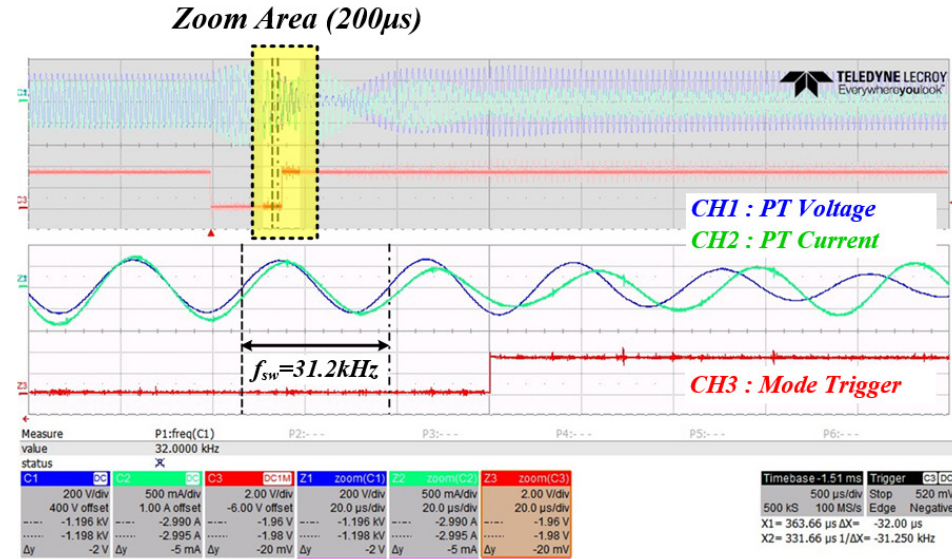
Figure 27. PT output waveform when mode 2 changes to mode 3 (CH1: PT voltage (blue), CH2: PT current (green), CH3: mode trigger (red)).